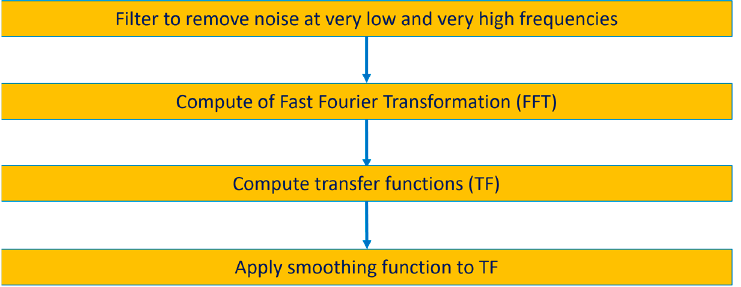
Figure 13. Flowchart of ambient data processing.